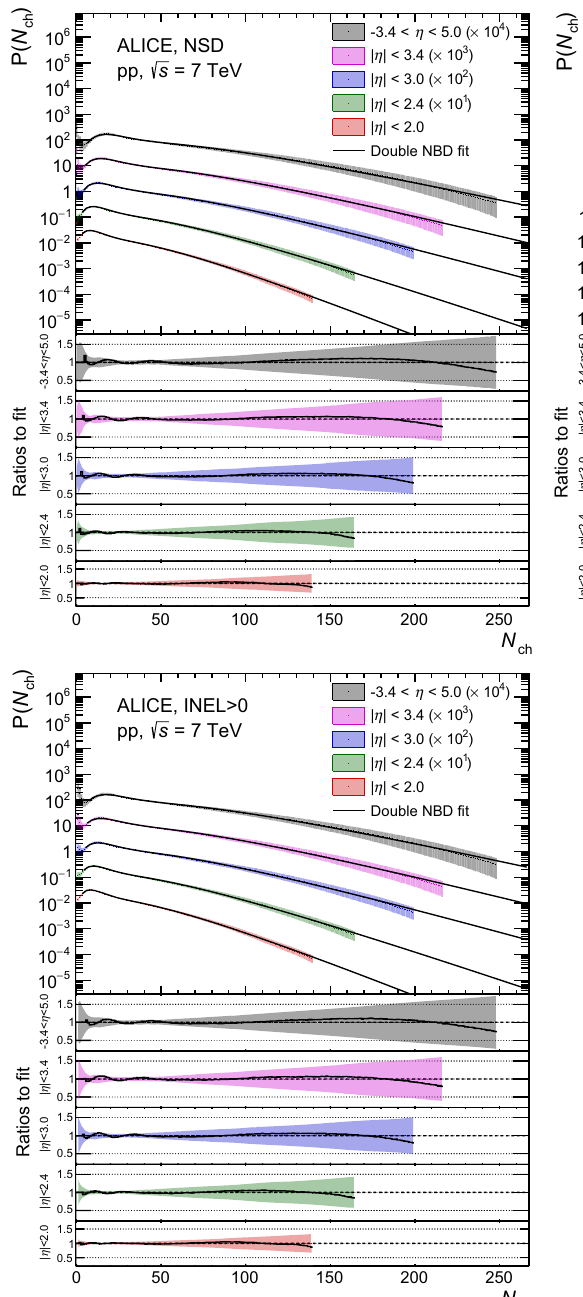
presented. Combined systematic and statistical uncertainties are shown √ s = 7 TeV. as